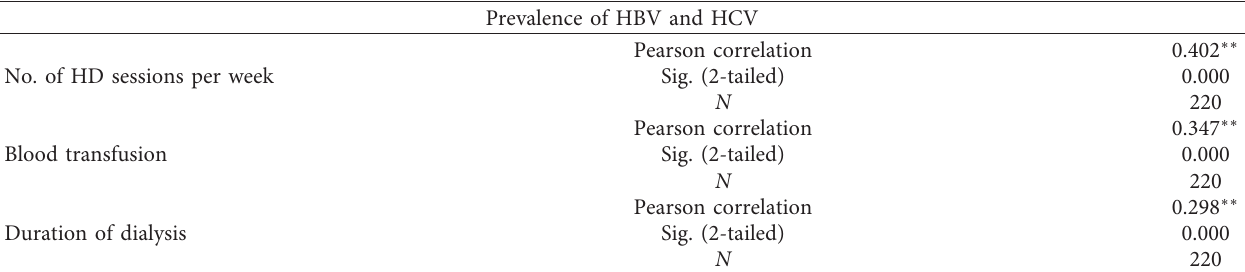
Table 4: The correlations between the prevalence of HBV and HCV and the number of hemodialysis sessions/week, blood transfusion, and duration of